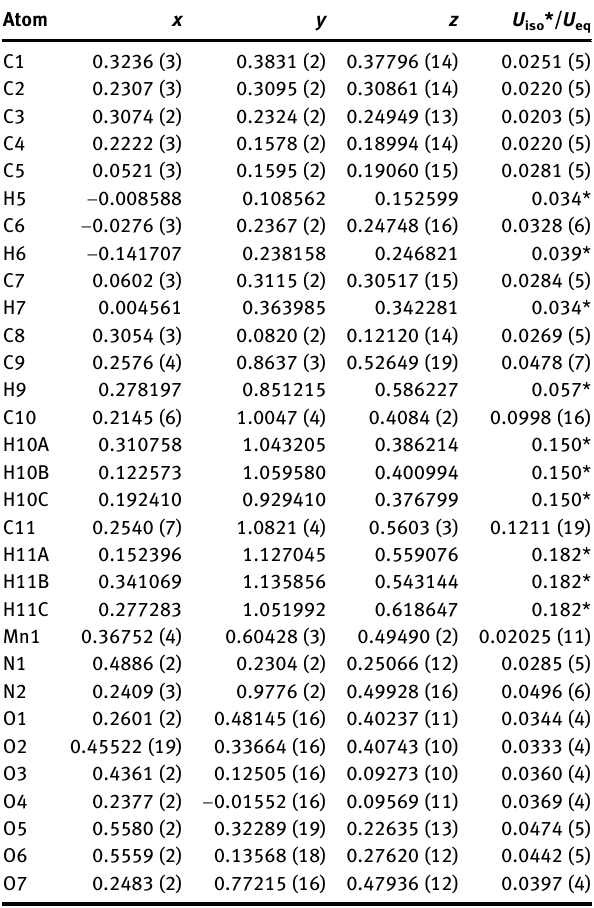
Table  : Fractional atomic coordinates and isotropic or equivalent isotropic displacement parameters (Å  ).